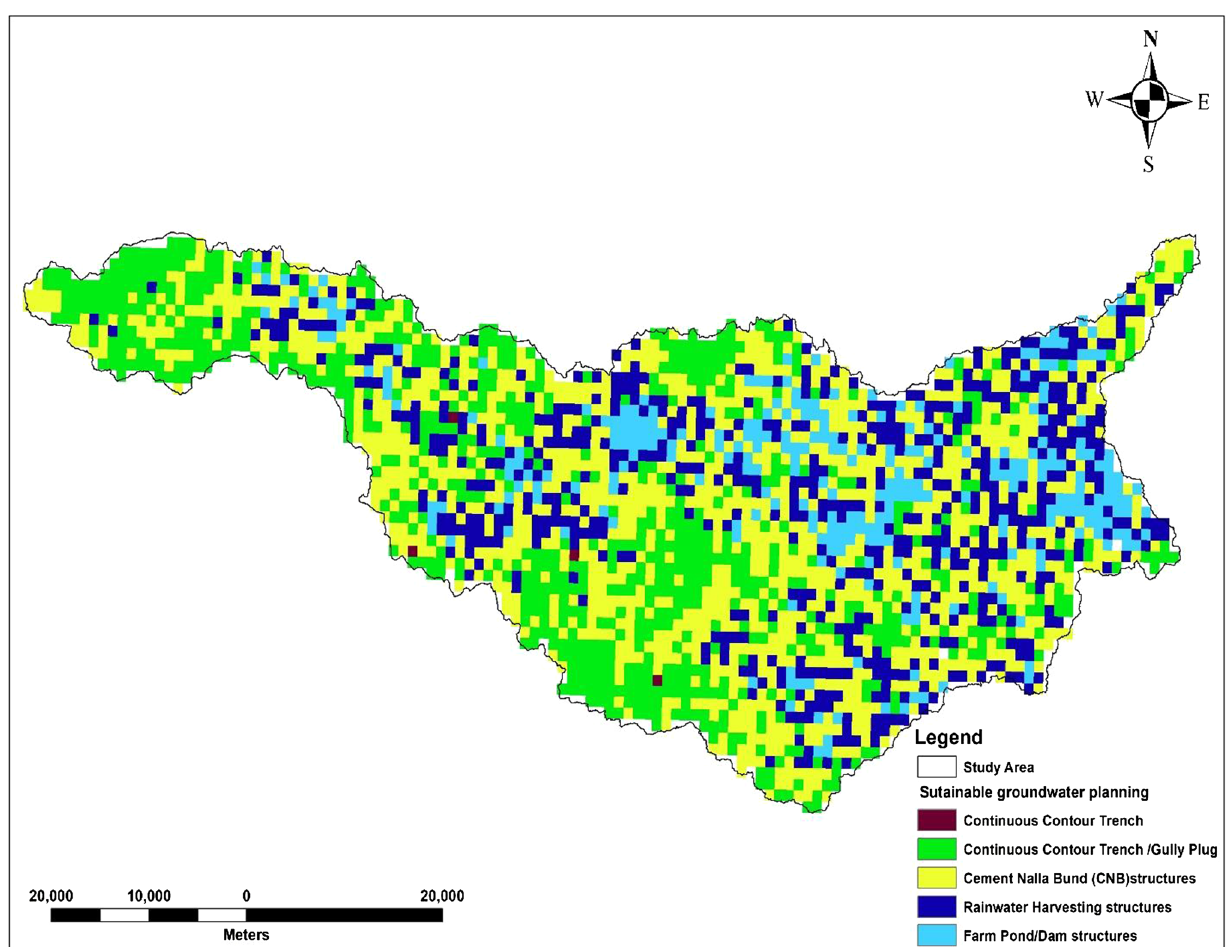
Fig. 8 Sustainable groundwater planning and development of Mula river basin